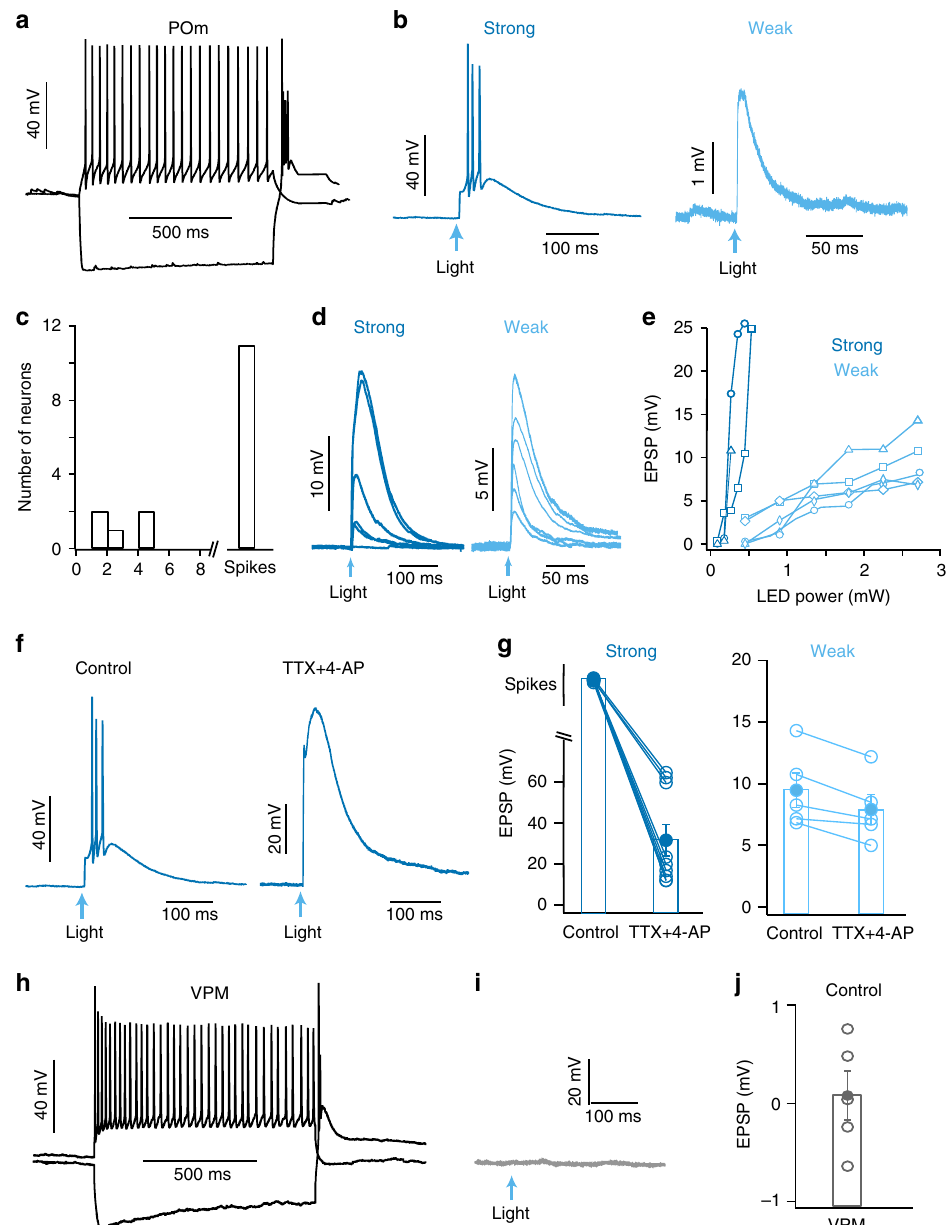
Fig. 5 POm, but not VPM, receives direct, monosynaptic input from SC. a Response of a POm neuron to somatic depolarizing ( + 300 pA) and hyperpolarizing ( − 400 pA) current injection. b Synaptic responses from POm neurons receiving “ strong ” (dark blue) and “ weak ” (light blue) SC input (LED power 0.8 mW). Arrows depict time of photo-activation of SC axons (2 ms). c Histogram of EPSP amplitude or presence of spiking in POm neurons during optogenetic activation of SC axons ( n = 16; LED power 0.8 mW). d Graded synaptic responses in POm neurons receiving “ strong ” (left; LED power 0.1 – 0.45 mW) and “ weak ” (right; LED power 0.45 to 2.72 mW) input from SC. e EPSP amplitude in different POm neurons plotted as a function of LED power in POm neurons receiving “ strong ” and “ weak ” SC input ( n = 3 and n = 5, respectively). f Synaptic responses in a POm neuron receiving “ strong ” SC input in control (left) and in the presence of TTX and 4-AP (right). g Summary of EPSP amplitudes or spiking in neurons that received “ strong ” (left; n = 9) and “ weak ” (right; n = 5) SC inputs in control and in the presence of TTX and 4-AP (LED power 2.72 mW). h Response of a VPM neuron to somatic depolarizing ( + 300 pA) and hyperpolarizing ( − 400pA) current injection. i Voltage response of the same VPM neuron to photo-activation of SC axons at maximum LED power (2 ms; 5 mW). j Summary of EPSP amplitude in VPM neurons ( n = 5) during optogenetic activation of SC axons at the highest LED power tested (5 mW). Error bars represent SEM. Source data are provided as a Source Data fi potential fi ring to whisker stimulation in 79% of vS1 whisker lidocaine was injected into POm (Fig. 7b, right). Pooled data responsive neurons in these experiments (Fig. 7d, left; 23 out of indicated that inactivation of POm lead to a statistically sig- 29; ROC analysis). Silencing POm signi fi cantly reduced the ni fi cant reduction in the response of vS1 neurons to optogenetic impact of SC activation on these vS1 neurons during 50 µm activation of SC (Fig. 7c; n = 36; p < 0.05 t -test). We next tested whisker de fl ections (Fig. 7d, right; n = 23; p < 0.05 ANOVA the impact of inactivation of POm on vS1 responses during brief interaction). Importantly, inactivation of POm had no impact on de fl ections of the whiskers. SC activation increased action